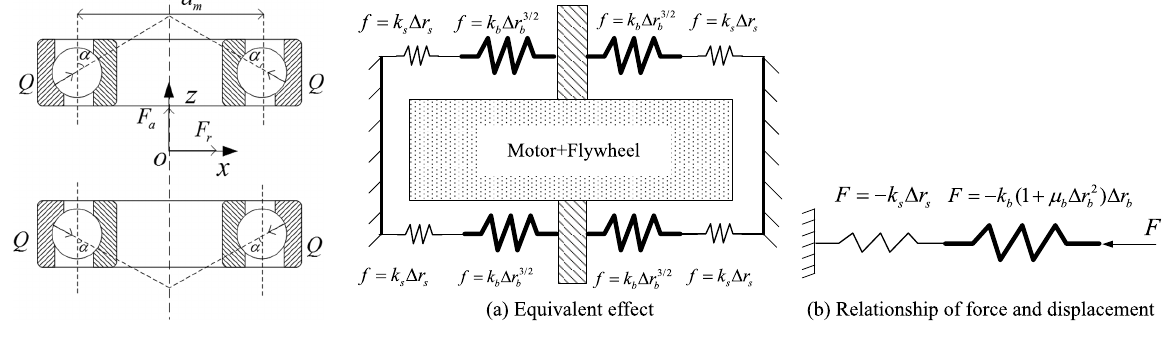
Fig. 2. Force analysis for the bearing. Fig. 3. Sketch of equivalent support